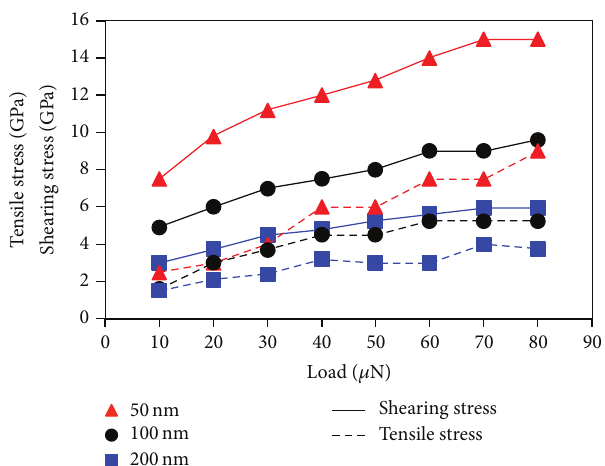
Figure 8: Load effects on maximum principle and shear stresses.